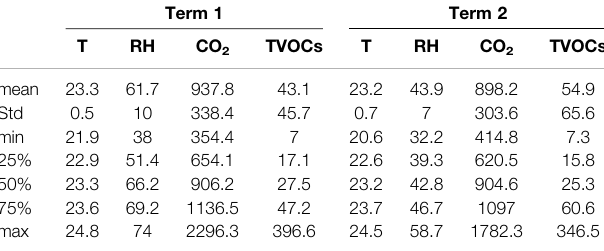
TABLE 4 | Statistical analysis for the print room over Term 1 and Term